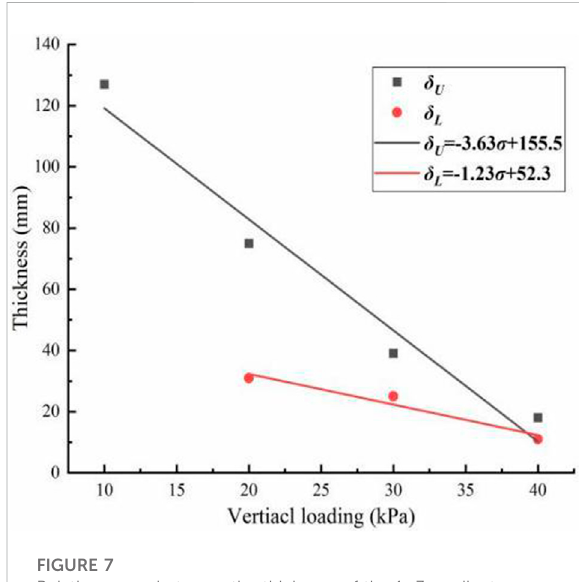
FIGURE 7 Relation curve between the thickness of the 1 – 3 gradient layer and the normal load.